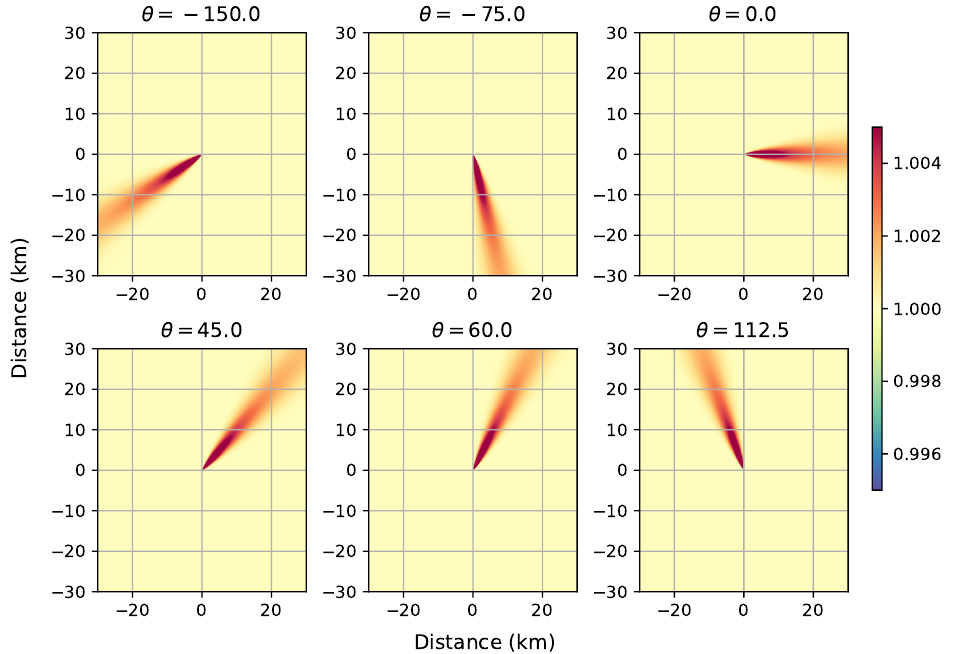
Figure 3. Simulated images of XCO 2 concentrations from a 13 Mt yr − 1 source relative to a constant 400 ppm background for six different wind directions. Angles are measured counter clockwise from the positive x -axis, or eastward. Panel labels identify the angle used for each panel.